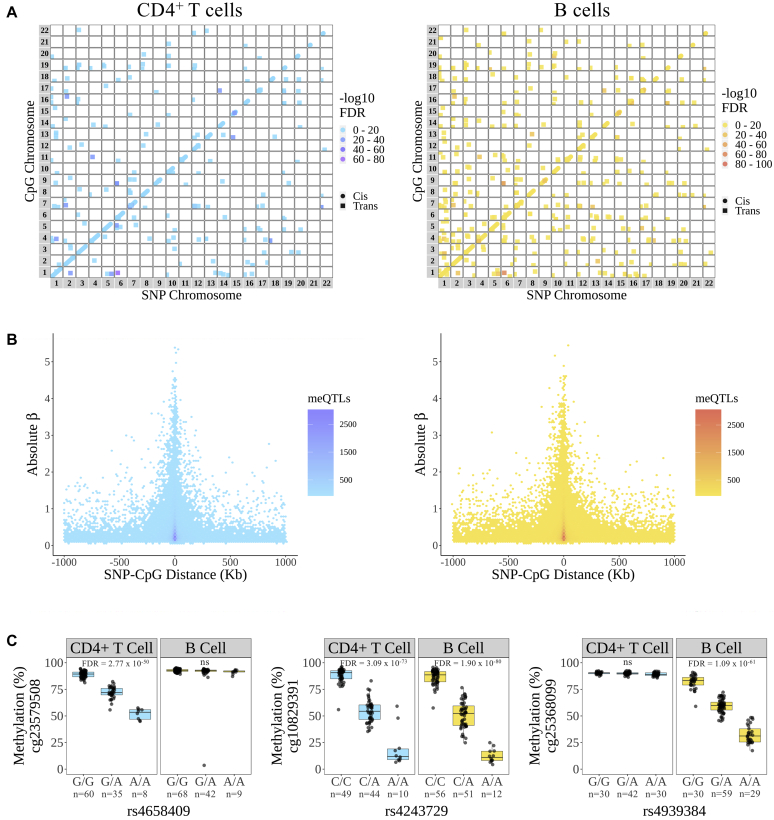
meQTL mapping genome-wide in CD4+ and B cells of patients with early arthritis. A, SNP and CpG coordinates of all independent cis/trans-meQTL effects mapped in both CD4+ T cells (left) and B cells (right) across patients with early arthritis. Cis-meQTLs denoted by circles and trans meQTLs by squares, with the color reflecting the −log10 FDR value of the association. B, Distance between regulatory SNP and its cognate CpG site plotted against effect size (absolute regression coefficient, β) for all cis-meQTLs. C, Exemplar plots of cis-meQTLs identified exclusively CD4+ T cells (left), common to both cell types (middle), or exclusively in B cells (right). Boxplots display the median, 25th and 75th percentiles. Whiskers extend to the highest/lowest value that is no greater than 1.5 3 interquartile range from the 75th/25th percentile, respectively.